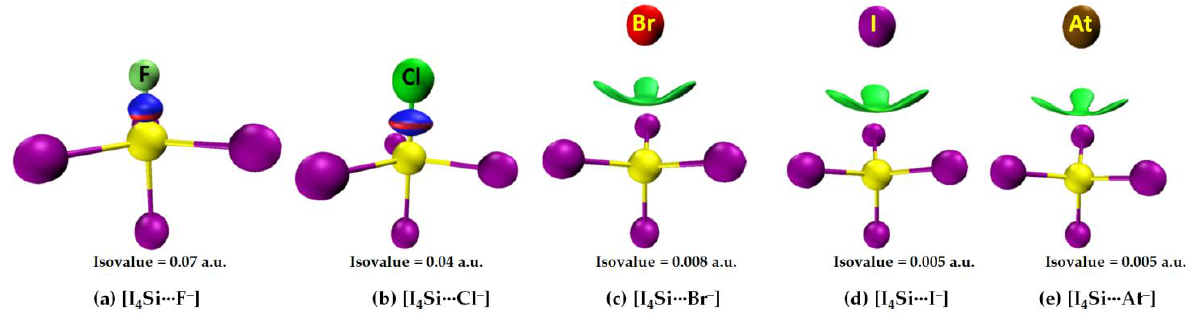
Figure 10. ( a – e ) [ωB97X -D/def2-QZVPPD] level IGM- δg inter -based isosurface (bluish-red or green volumes) plots for [I 4 Si···X − ] (X = F, Cl, Br, I, At), showing possible I···X halogen-halogen bonded and Si···X tetrel bonded interactions between interacting molecular entities. In the case of [I 4 Sn···X − ] and [I 4 Pb···X − ] (X = F, Cl, Br, I, At), the IGM- δg inter isosurfaces were visualizable with an isovalue close to 0.055 a.u. Figure 11 shows this for the [I 4 Pb···X − ] series. Passing from the left to the right of Figure 11, it can be seen that the thickness and size of the bluish isosurface volume describing the dative tetrel bond between Tt and X are decreasing. This result is also in agreement with QTAIM in that the charge density between these atomic basins decreases from [I 4 Tt ··· F − ] through [I 4 Tt ··· Cl − ] to [I 4 Tt ··· Br − ] to [I 4 Tt ··· I − ] to [I 4 Tt ··· At − ] (Tt = Sn,